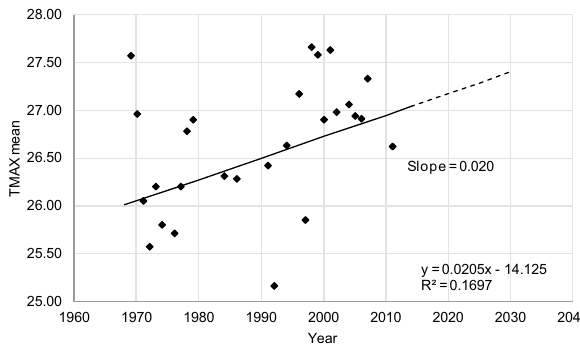
Fig. 12 Indices monthly mean value of daily maximum temperature Azraq forecasting till 2030